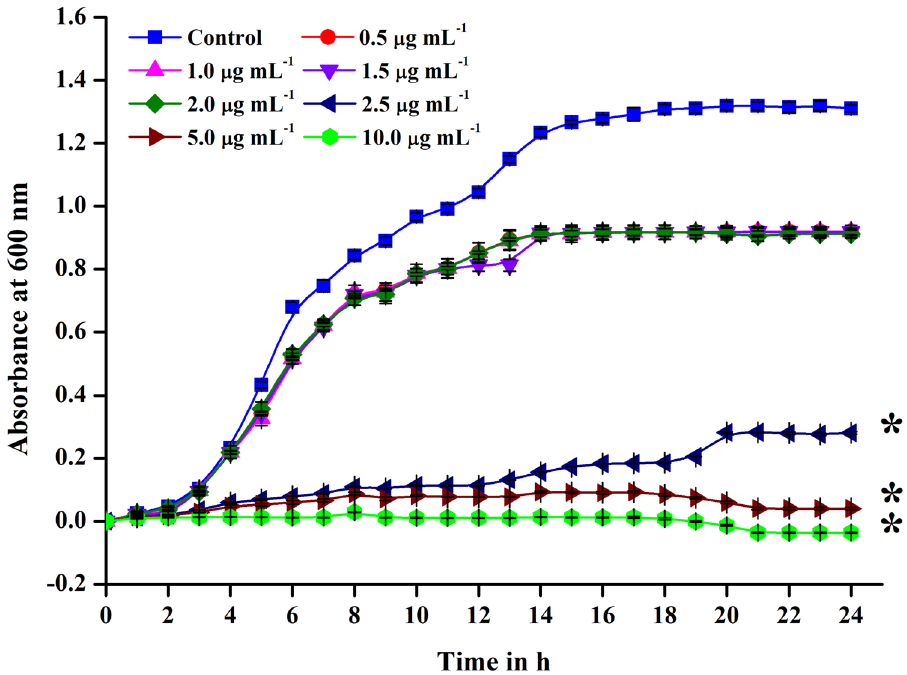
Figure 3. Comparative killing kinetics of UA. MBC, MIC and sub-inhibitory concentrations (0.5, 1, 1.5, 2 and 2.5 µg mL −1 ) of UA was assessed for the time dependent growth inhibition. Substantial reduction in growth was noted when treated with concentration from 2.5 µg mL −1 of UA whereas no proliferation of cells was found at MBC from 0 to 24